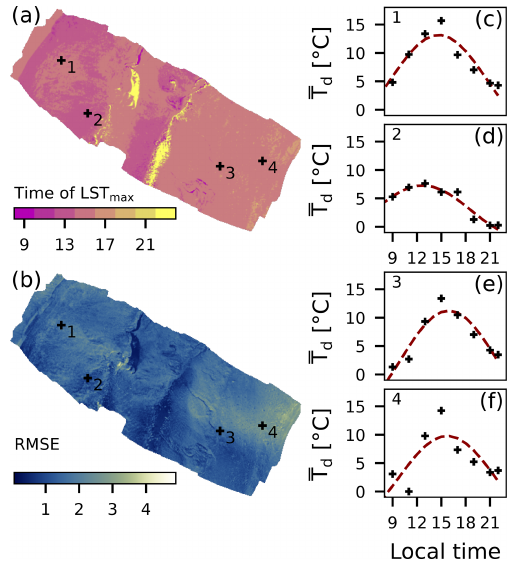
Figure 5. Sinusoidal regression of mean debris temperature ( T d ), estimated from LSTs (Eq. 6) for each pixel. (a) The panel shows the time at which T d reaches its maximum diurnal temperature and thereby emphasizes the effect terrain aspect. (b) The RMSE of the regression for each pixel. The southeastern region with larger errors is due to the anomalies in the LST at 11:00 (UTC + 1); see the text for details. The spatial mean of the RMSE is 1.51 ◦ C, and the stan- dard deviation is 0.54 ◦ C. The panels (c–f) are example points of the sine function used to derive the warming/cooling rate in each pixel. Locations of the examples are indicated in panels (a) and (b)